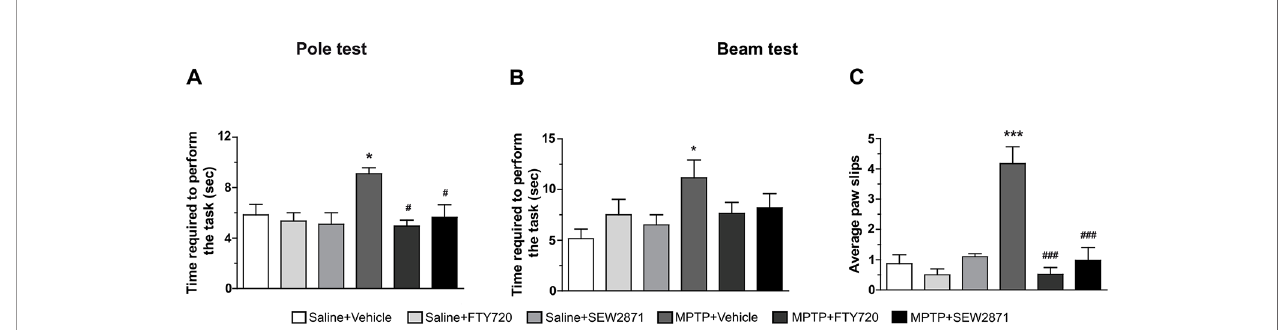
FIGURE 7 | Motor behavioral outcomes. Motor abilities on the pole and beam tests were evaluated. Data represent the mean time require to perform the pole (A) and beam (B) tests and the mean number of foot-faults occurring during the beam test (C) ± S.E.M., n = 3 – 5 mice/group. * p < 0.05, *** p < 0.001 vs . vehicle + saline; # p < 0.05, ### p < 0.001 vs . vehicle